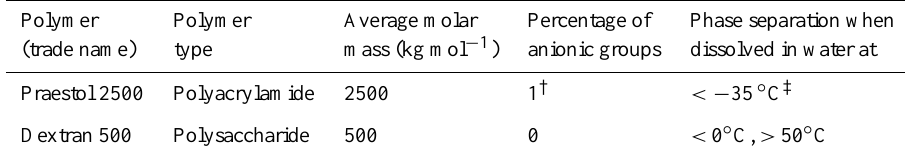
Table 2. Properties of the polymers used in the polymer tensiometers. Polymer Polymer Average molar Percentage of Phase separation when (trade name) type mass (kg mol − 1 ) anionic groups dissolved in water at Praestol 2500 Polyacrylamide Dextran